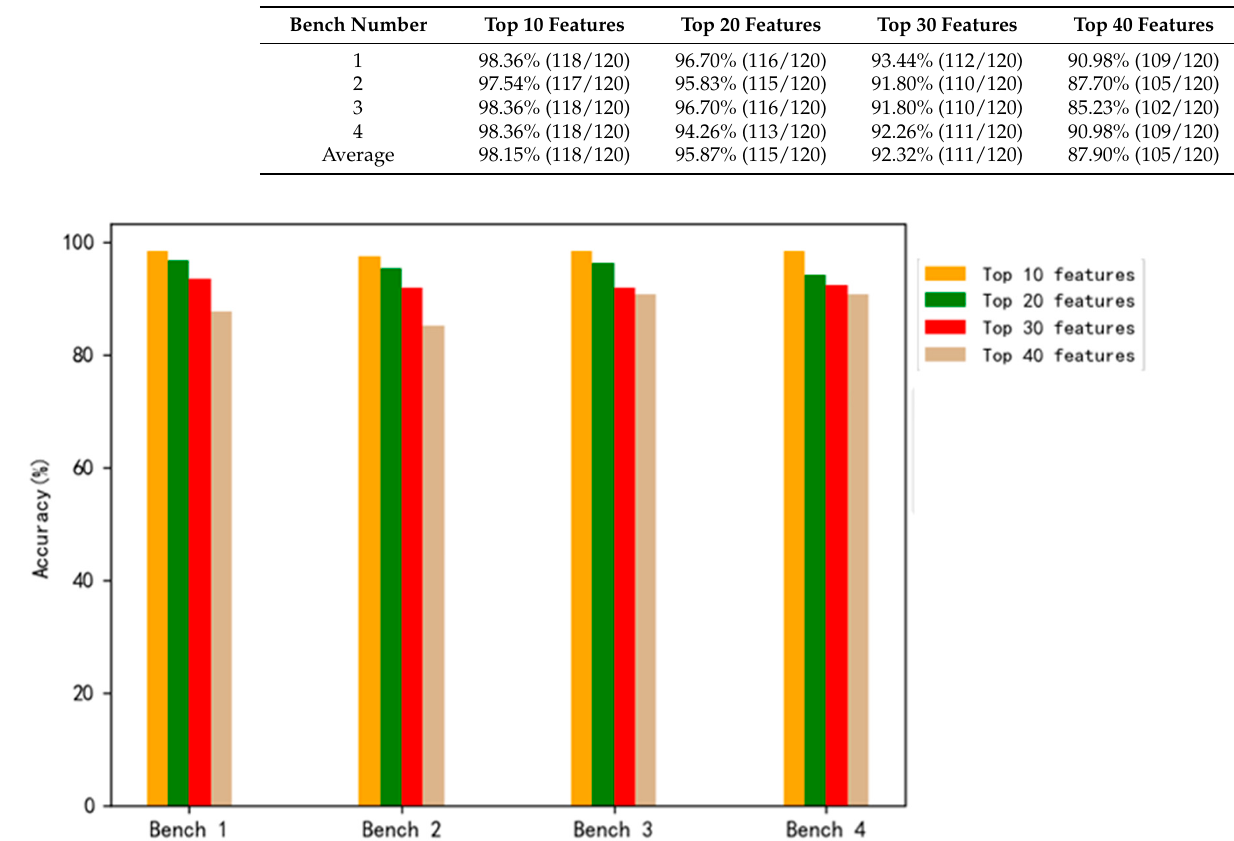
Figure 11. Diagnostic results under different feature datasets.